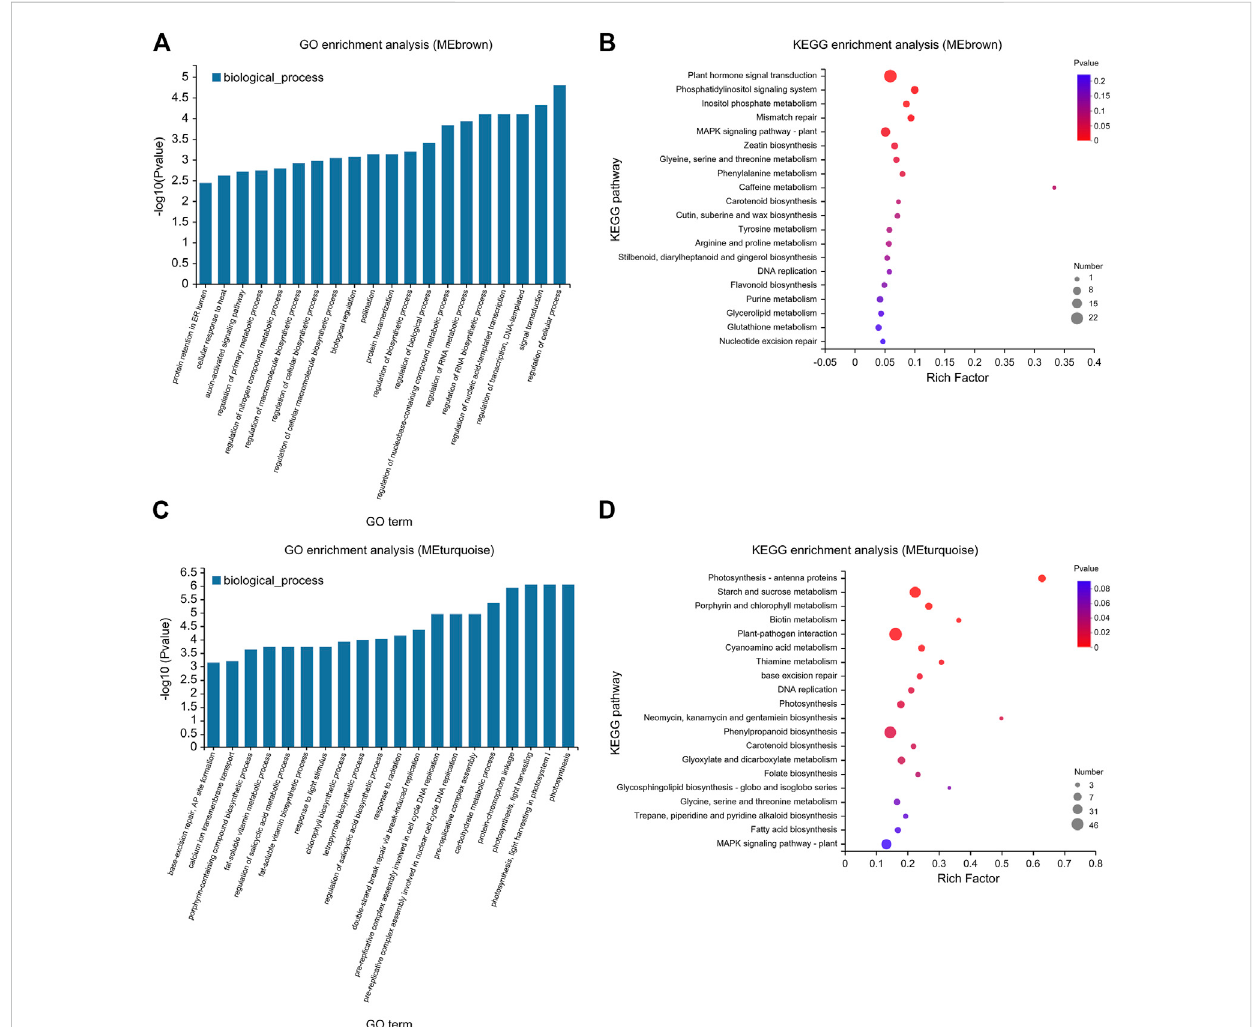
FIGURE 8 GOand KEGGenrichmentmapofMEbrownand MEturquoise modules usingtheWGCNA. (A) GO and (B) KEGGpathways enriched intheMEbrown module. (C) GO and (D) KEGG pathways enriched in the MEturquoise module. (A,C) The abscissa represents GO terms, and the ordinate represents the enrichment signi fi cance level, which corresponds to the height of the column. The larger the -log10 ( p -value) value, the more signi fi cantly enriched the GO term. (B,D) The enrichment factor is de fi ned as the ratio of the DEGs annotated in a pathway term to all the genes annotated in that pathway term. The greater the enrichment factor, the greater the degree of pathway enrichment. The bubble sizes represent the number of genes enriched in a KEGG pathway. The bubble color represents the p